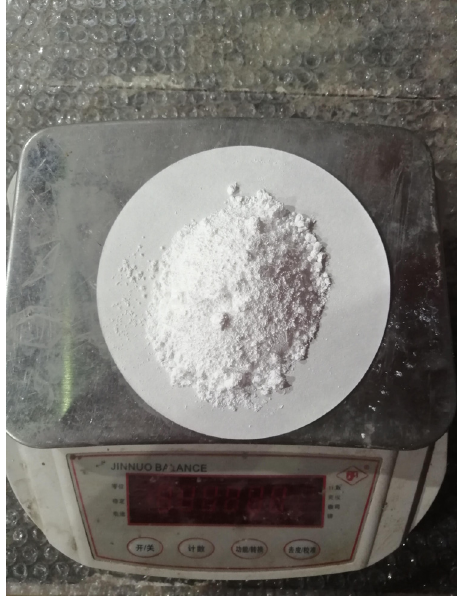
Figure 2: Nano - CaCO 3 powder.